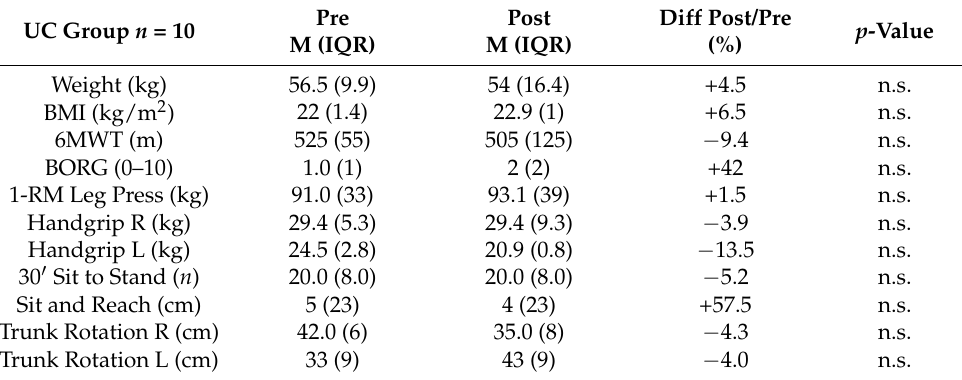
Table 5. Pre- and post-Functional evaluation UC group. Abbreviation: M = Median; IQR = Interquar- tile Range; Diff = Differences in percentage; n = numbers; BMI = Body Mass Index; 6MWT = Six min walking test; 1-RM = One Repetition Maximum; R = right; L = left; n.s. = no statistical significance. Pre UC Group n = 10